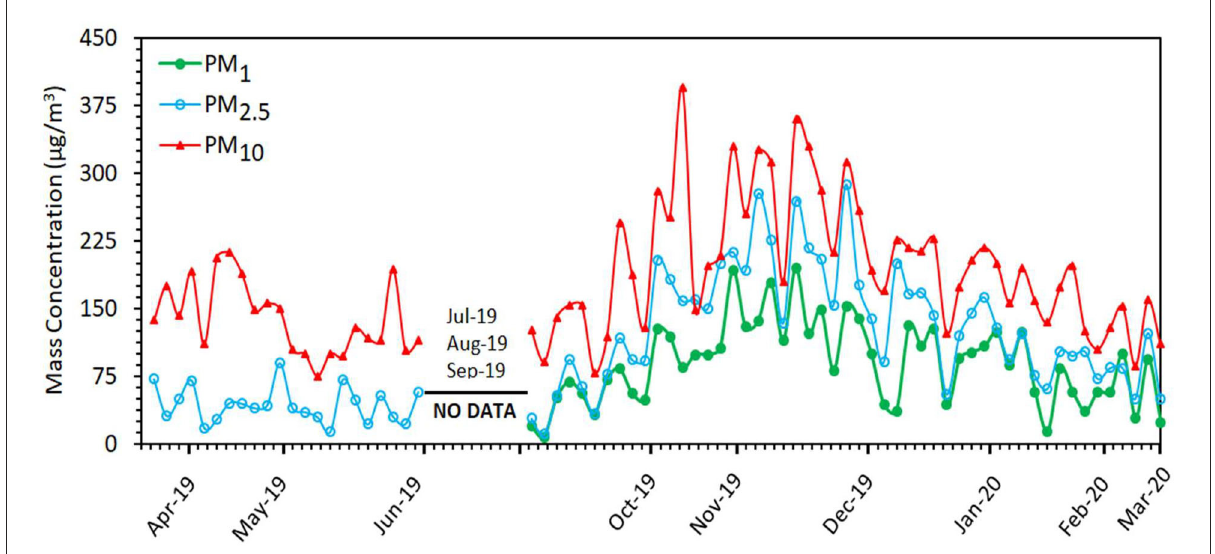
FIGURE2 Daily variation in mass concentration of particulate matters (PM 1 , PM 2.5 , and PM 10 ) from April 2019 to March 2020 over Varanasi.